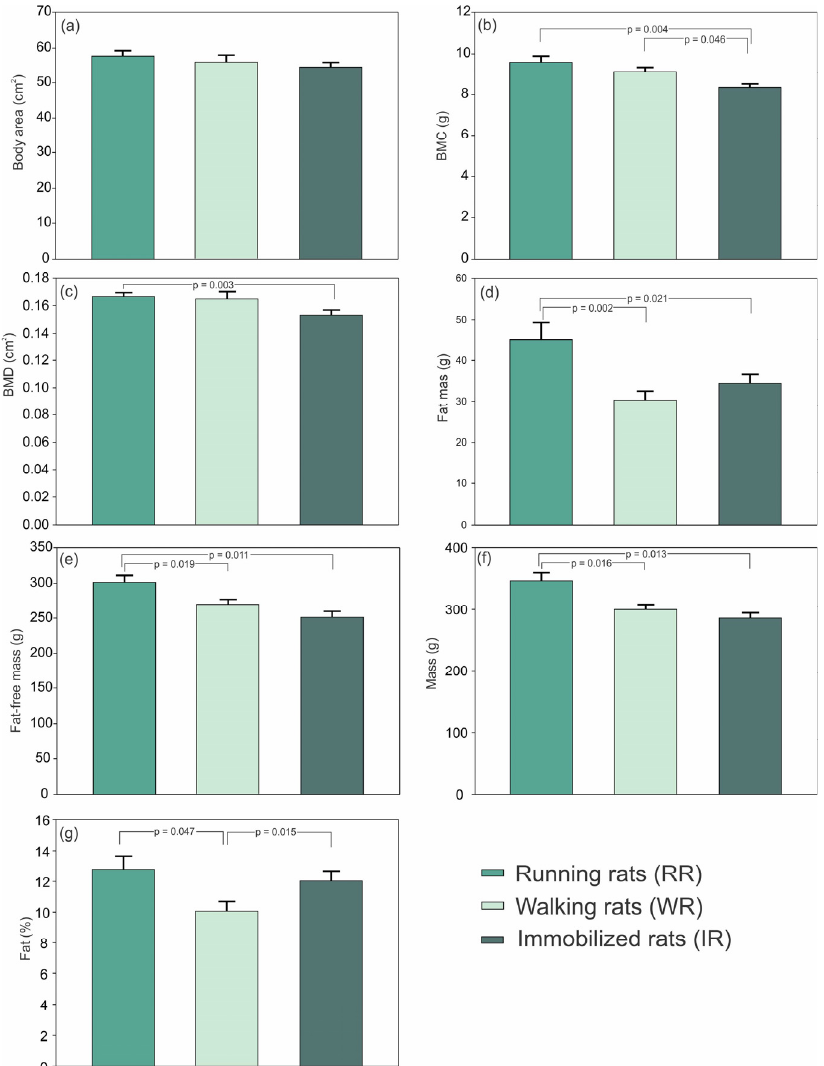
Figure 2. Mean (±SD) parameters of the whole body of rats treated with different types of move- ments. ( a ) body area (cm 3 ); ( b ) BMC—bone mineral content (g); ( c ) BMD—bone mineral density (cm 2 ); ( d ) fat mass (g); ( e ) fat-free mass (g); ( f ) mass (g); ( g ) fat (%). Ten animals were included in each group.